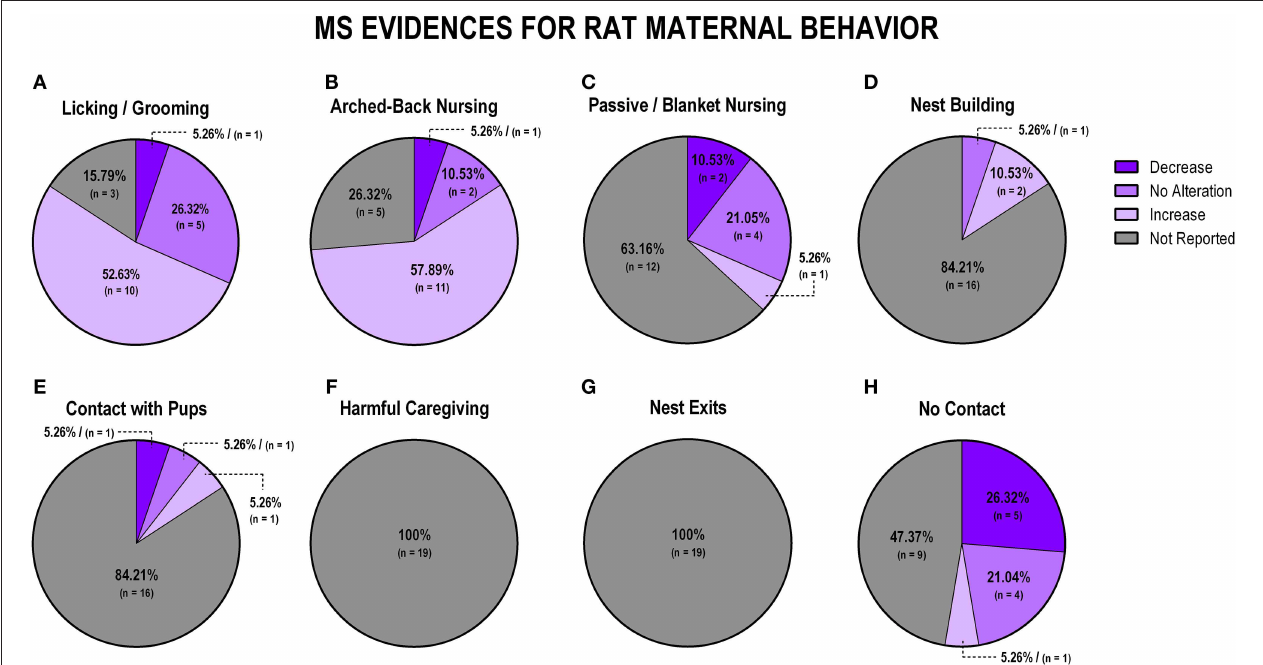
FIGURE 5 | Percentage of behavior findings from MS rat studies. Licking and grooming behavior (A) . Arched-back nursing behavior (B) . Passive and blanket nursing behavior (C) . Nest building behavior (D) . Contact with pups behavior (E) . Harmful caregiving behavior (F) . Nest exits behavior (G) . No contact behavior (H) .